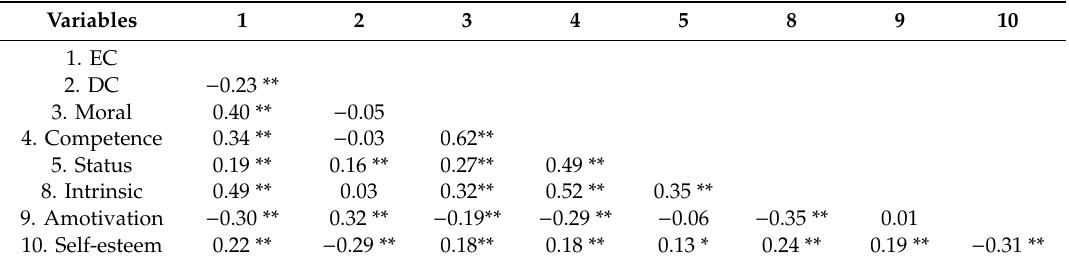
Table 4. Correlations between EDMCQ-C subscales and values, motivation in sport and self-esteem variables.